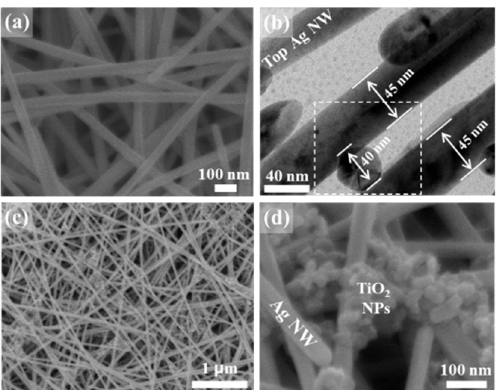
Figure 1. ( a ) SEM and ( b ) TEM images of 3D stacked Ag NWs. ( c , d ) SEM images of 3D hybrid nanostructures consisting of TiO 2 NPs and 3D Ag NWs. The image clearly shows the compact integration of TiO 2 NPs onto the crossed region of the 3D Ag NWs.